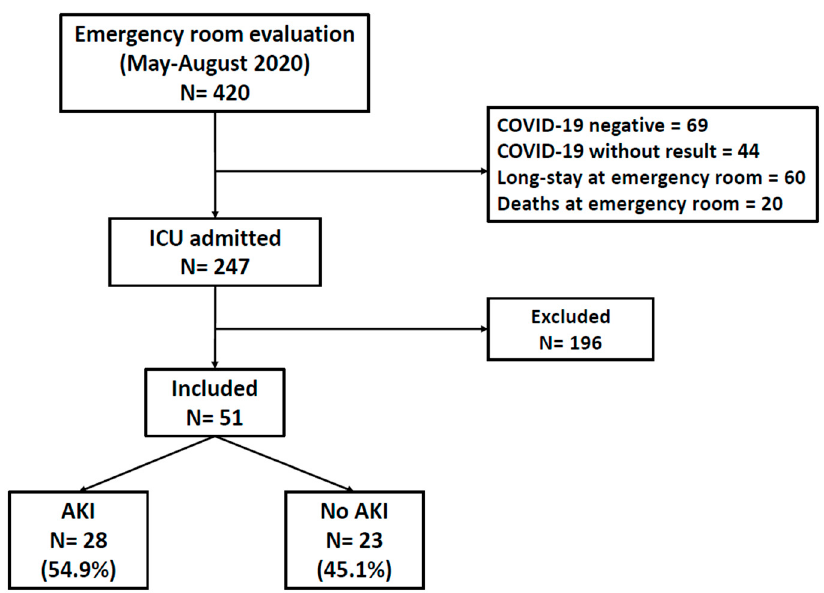
Figure 1. Study diagram. Numbers of individuals that were assessed for eligibility and individuals that were included in the study.